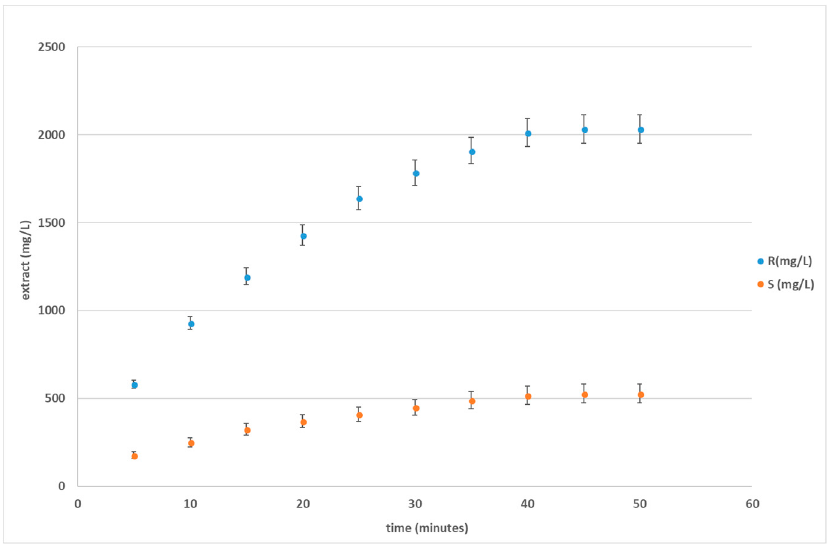
Figure 2. Diagram of the kinetics of the hot-batch extraction (with error bars) of rebaudioside A (blue, above) and stevioside (orange, under).